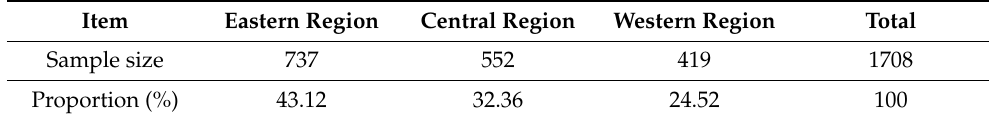
Table 1. Basic information about the provincial distribution of effective